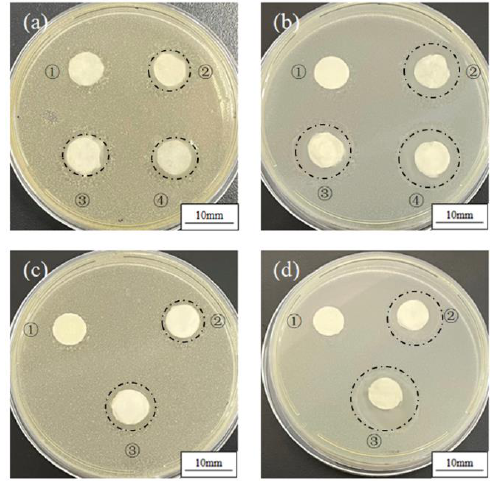
Figure 5. Inhibition zone of S. aureus ( a ) and E. coli ( b ) : ① , ② , ③ , and ④ refers to TTE-PVP-3, TTE-PVP-3/TTO-PCL, TTE-PVP-2/TTO-PCL, and TTE-PVP-1/TTO-PCL; effects of electrostatic spraying time on the inhibition zone against S. aureus ( c ) and E. coli ( d ) : ① , ② , and ③ refers to TTE-PVP-3, TTE-PVP-3/TTO-PCL, and TTE-PVP-3/TTO-PCL-2, respectively.